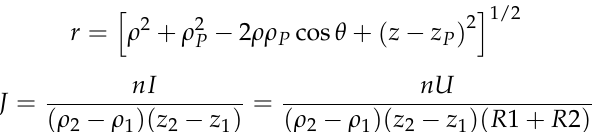
B; 3-drill-stem joint; 4-drill stem; 5-current coil.